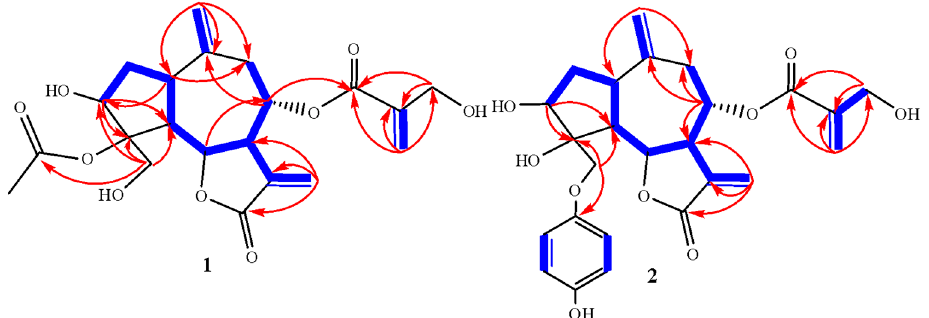
Figure 2. Observed 1 H ‐ 1 H ‐ COSY (bold blue line) and HMBC (red arrow) correlations for 1 and 2.